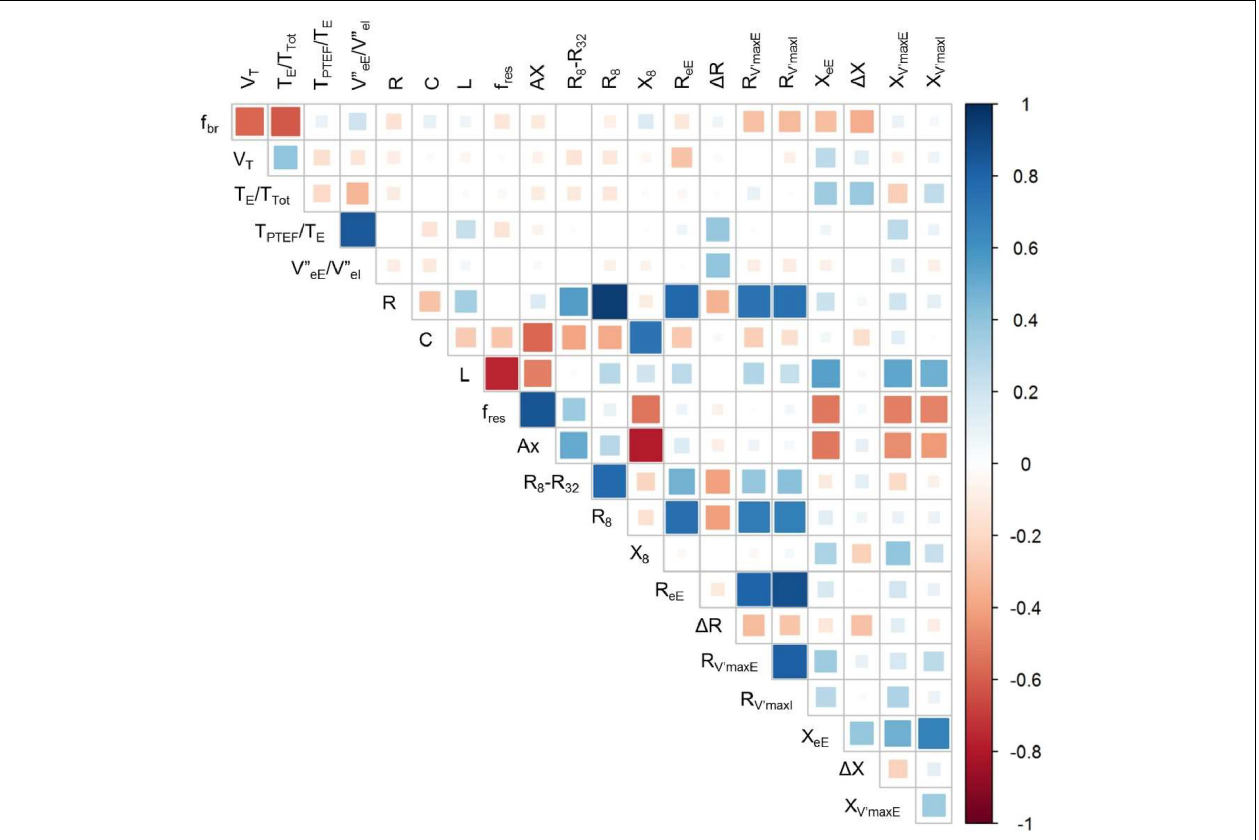
FIGURE 5 | Correlogram for selected measures of tidal breathing, spectral oscillometry and intra-breath oscillometry. For definition of variables, see legend to Table 4 .